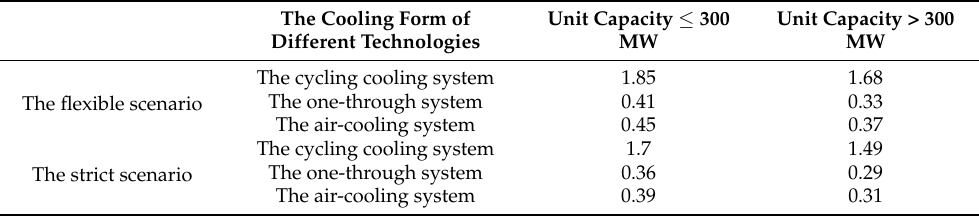
Table 2. The water withdrawal factor of different technologies under two scenarios (m 3 /MWh).